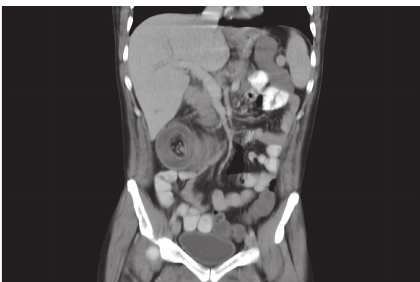
Figure 1: Coronal reconstruction of contrast enhanced abdomen and pelvis CT showing long segment of ileocolic intussusception with classic target/“doughnut”